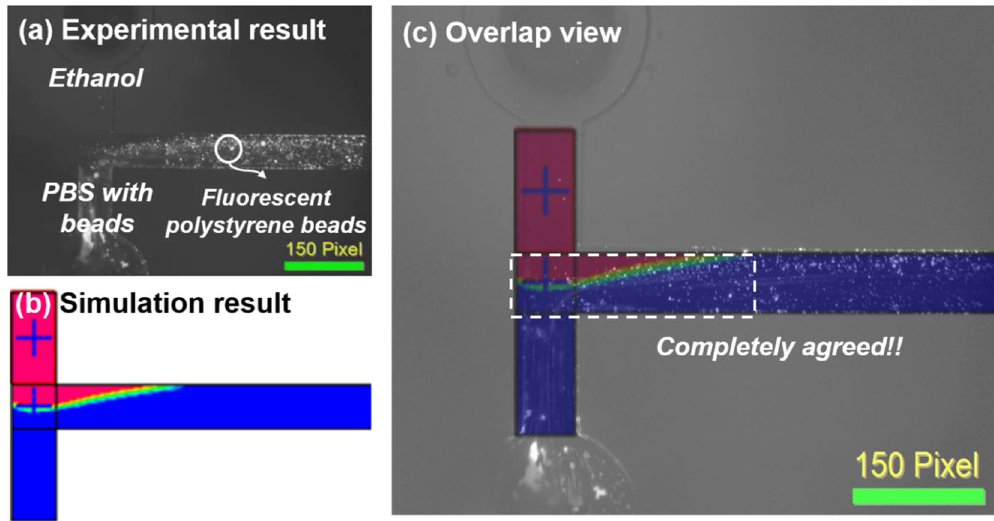
Figure 4. A bottom view of microchannels taken by an inverted microscope; ( a ) the experimental result of a flow pattern which was made by injecting 3 μL/min of PBS including fluorescent polystyrene beads with 9 μL/ min of ethanol, ( b ) simulation result in the same geometric and flow conditions to the flow experiment in ( a ), ( c ) an overlapped image of ( a ) and ( b